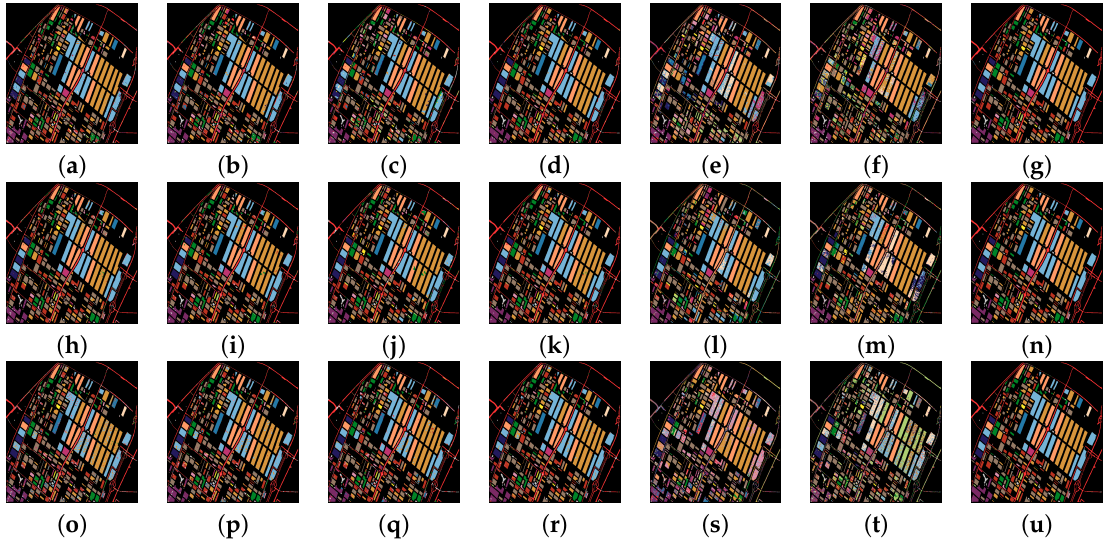
Figure 9. The classification image of the Flevoland dataset. The first to third rows are the classification results of P-, L-, and C-band, respectively. The different columns are the results of different methods. ( a , h , o ) CNN [19]. ( b , i , p ) CV-CNN [20]. ( c , j , q ) 3D-CNN [21]. ( d , k , r ) SViT [43]. ( e , l , s ) WMM [7]. ( f , m , t ) SVM [14]. ( g , n , u ) The proposed